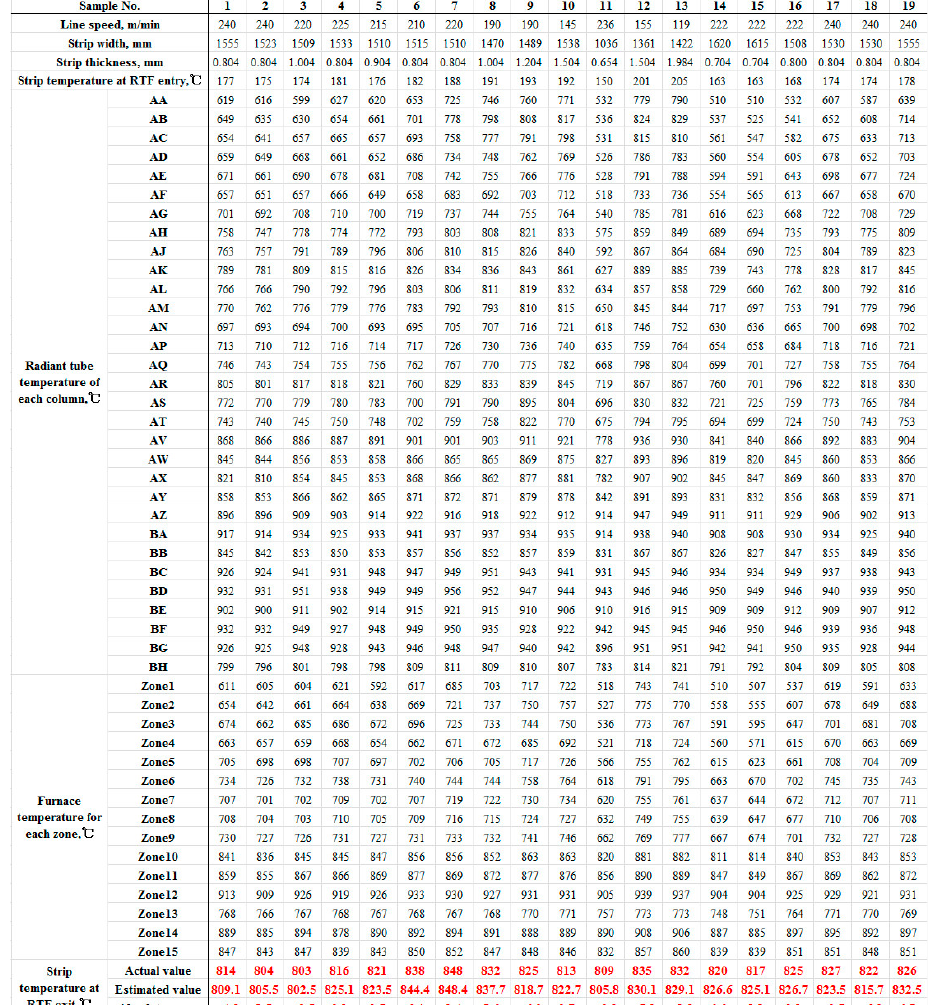
Figure 4. Results from verification experiments of the calculation model of strip temperature distri- bution in the RTF.